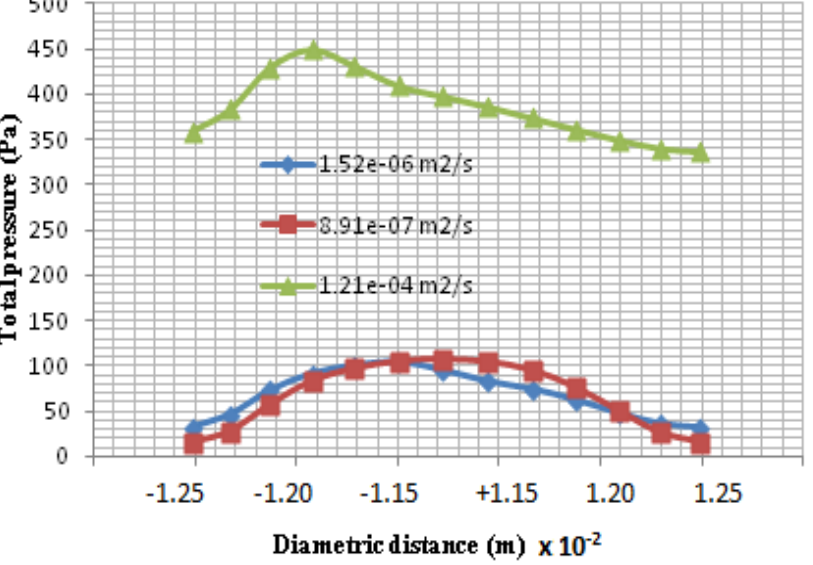
Figure 8. Oil phase kinematic viscosity changes affecting total pressure of